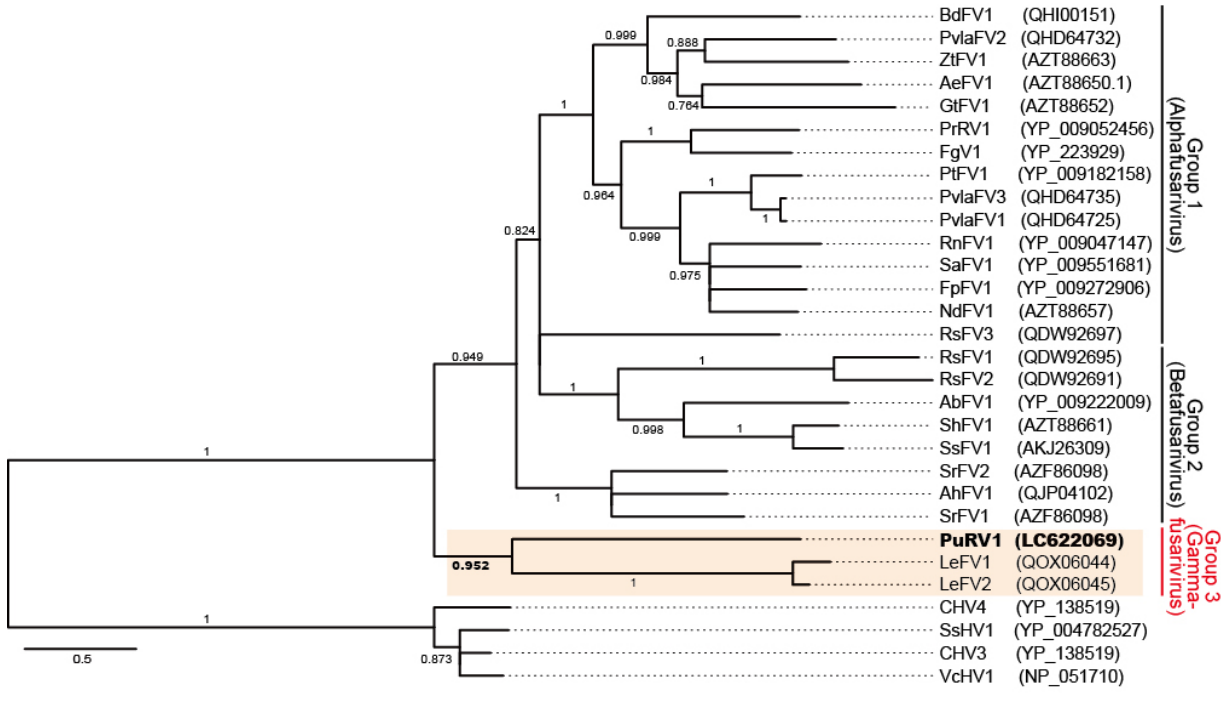
Figure 3. The maximum likelihood tree (LG + I + G + F) based on amino acids of RdRp from fusariviruses. RdRps of hypoviruses (CHV3, CHV4, SsHV1, and VcHV1) were used for rooting. The numbers on branches indicate the results of SH-like approximate likelihood ratio tests (aLRTs). Branch support values larger than 0.6 are shown. Scale bar shows substitutions per site.